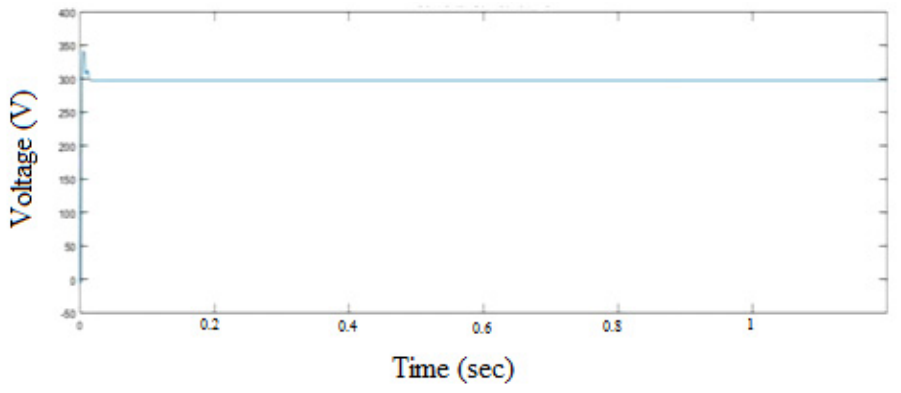
Fig 6: Output voltage/current of the converter